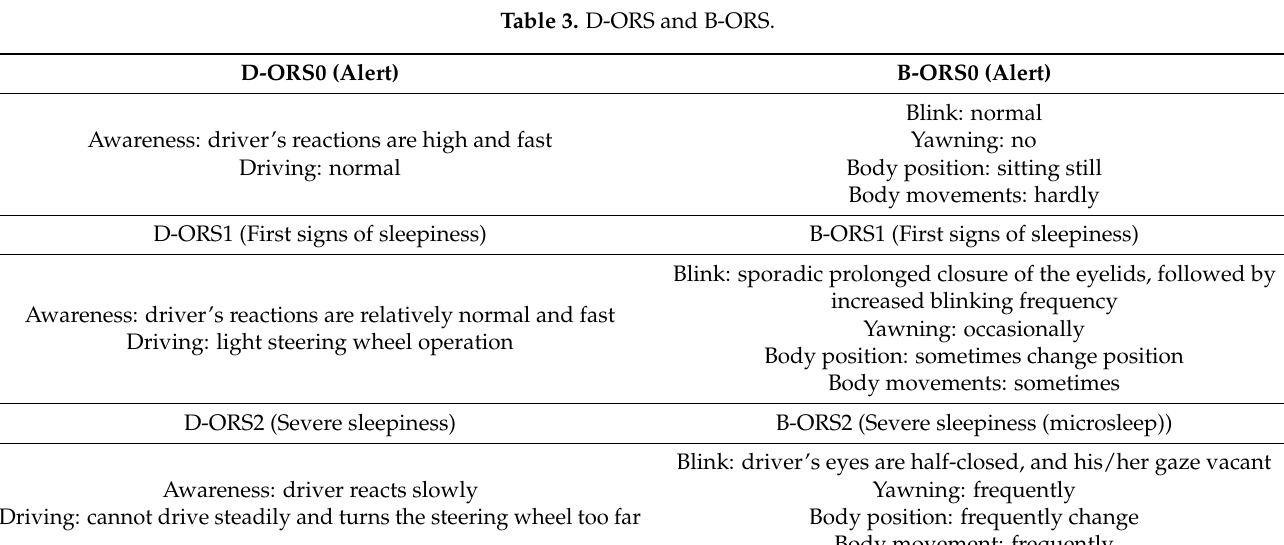
Table 3. D-ORS and